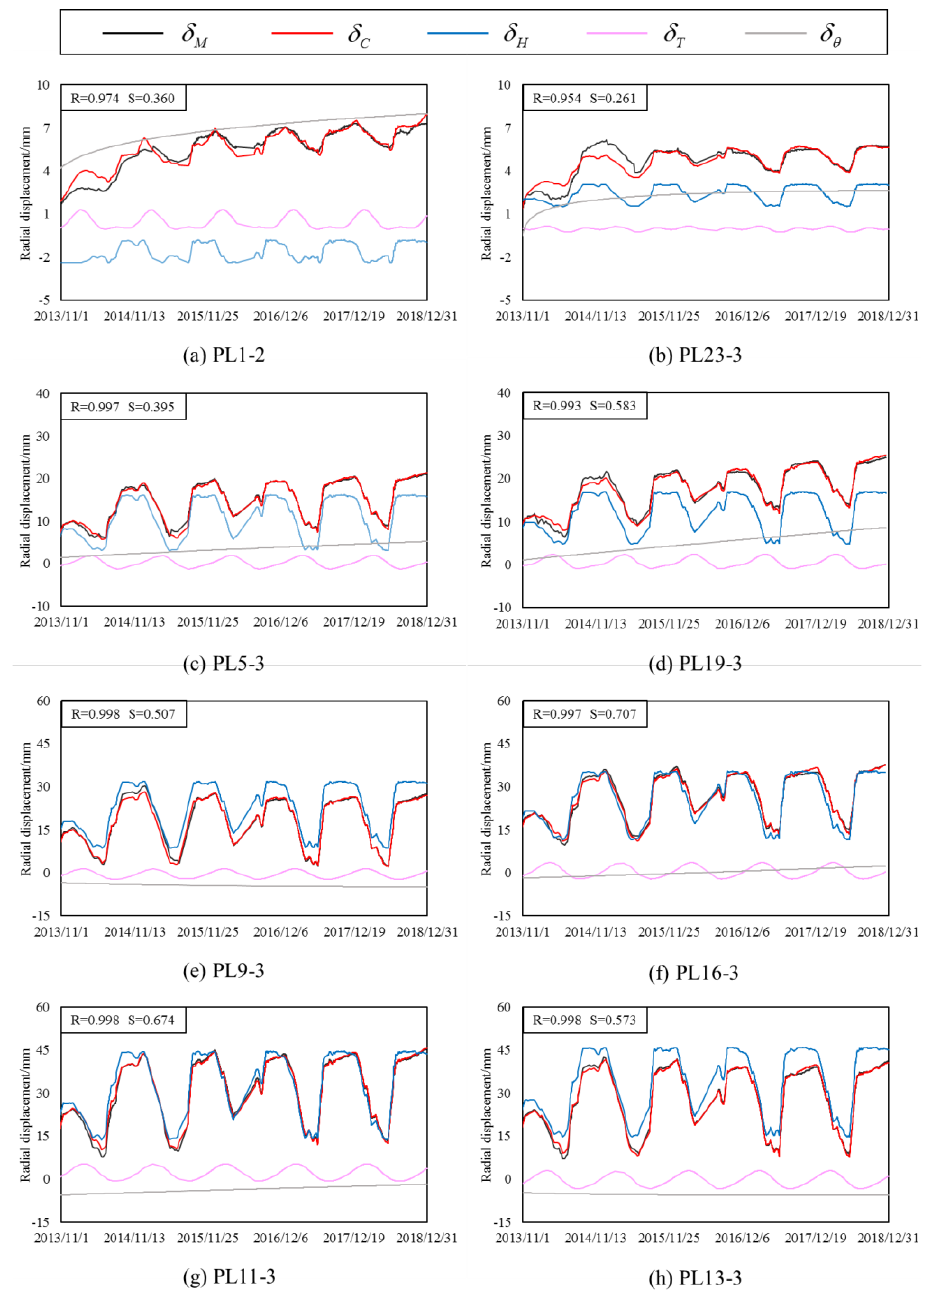
Figure 17. Fitting results of radial displacement hybrid model and component separation results of some dam sections.